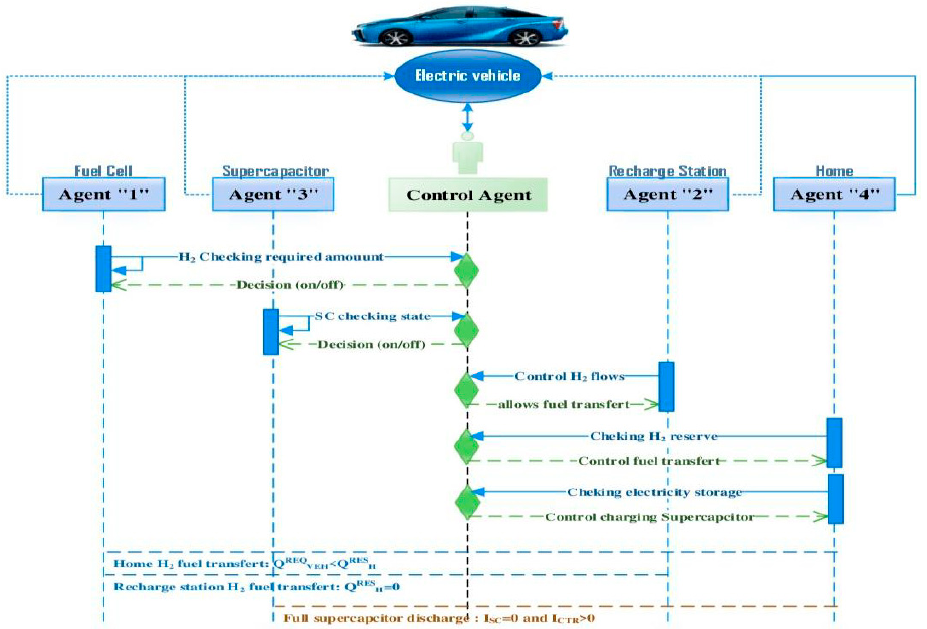
Figure 2. Sequence diagram for distribution flow control.